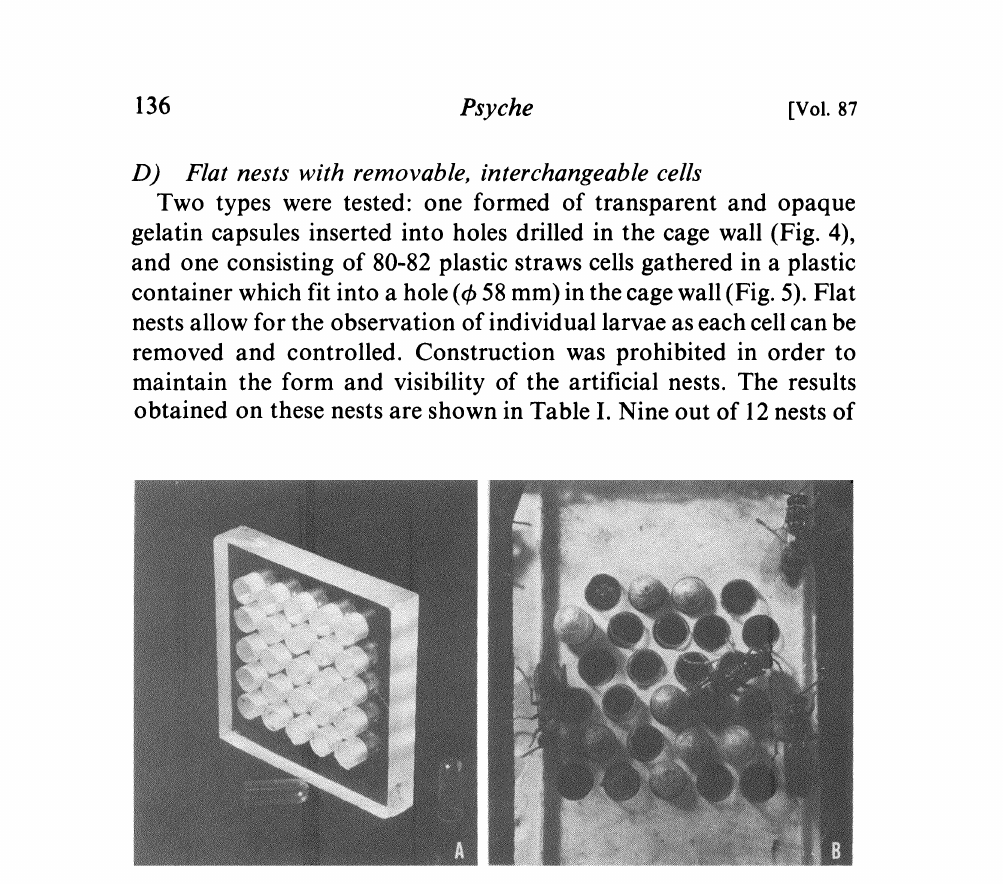
Fig. 4. Flat gelatin-capsule nest before and during use.